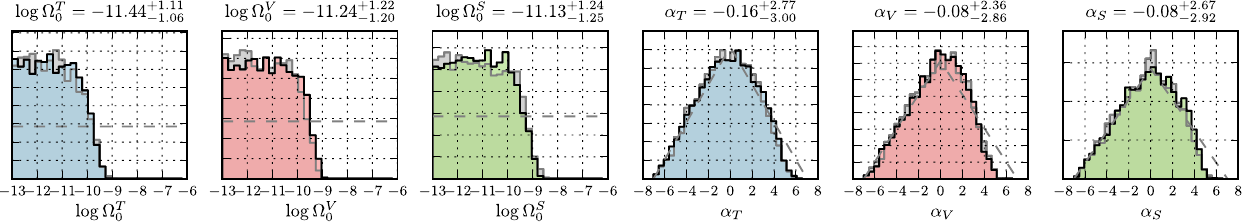
FIG. 11. Marginalized amplitude and slope posteriors for the Gaussian noise observation in Fig. 10, after the additional inclusion of design-sensitivity Advanced Virgo. For reference, the light gray histograms show the Advanced-LIGO-only results from Fig. 10. As above, dashed gray lines show the priors placed on each parameter. We see that the inclusion of Advanced Virgo does not significantly affect the parameter estimation